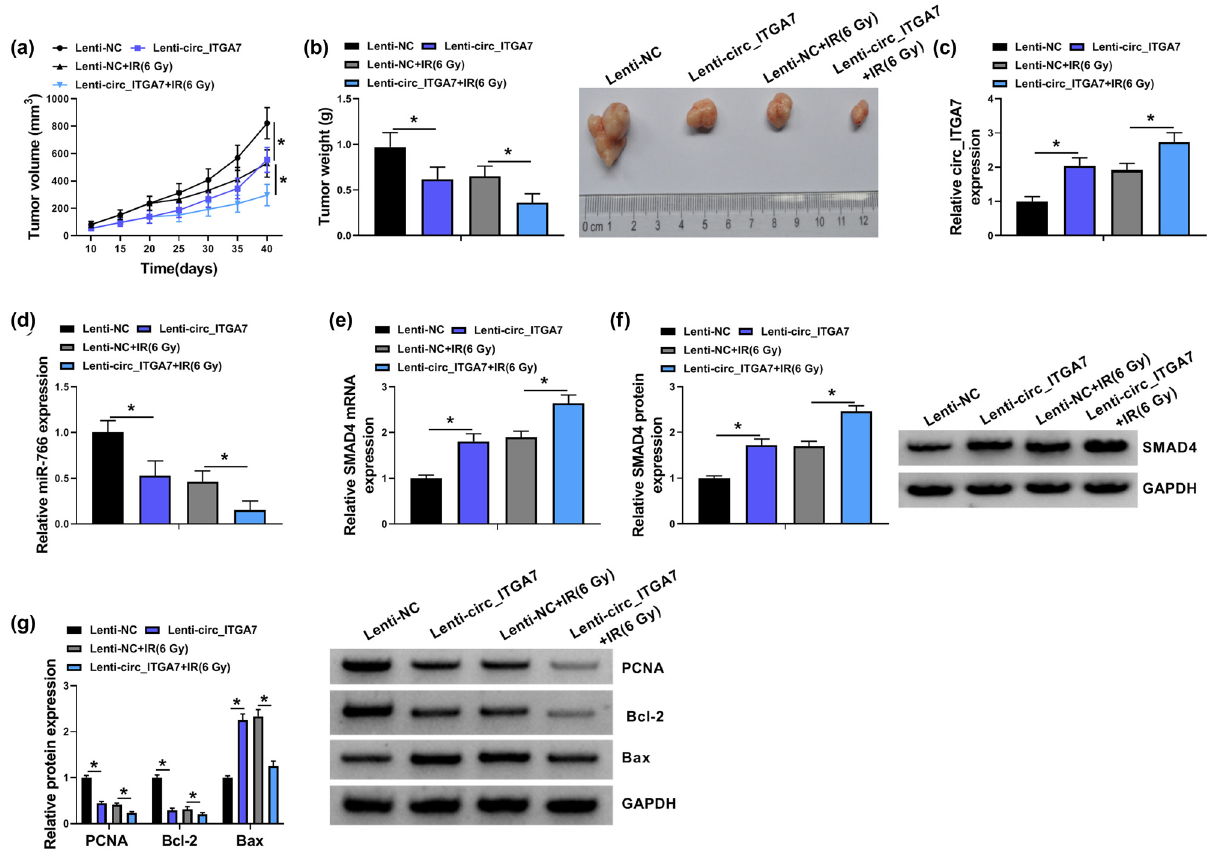
Figure 8: circ_ITGA7 impedes tumor growth and enhances irradiation sensitivity in vivo. ( a ) Tumor volume of each group was measured every 5 days starting 10 days after inoculation. ( b ) Tumor weight of each group was analyzed at Day 40 and the representative images of xenografts are shown. ( c – f ) qRT - PCR and western blot analysis of circ_ITGA7, miR - 766, and SMAD4 expression levels in tumors isolated from mice of each group. ( g ) Western blot analysis of PCNA, Bcl - 2, and Bax protein levels in tumors isolated from mice of each group. * P <